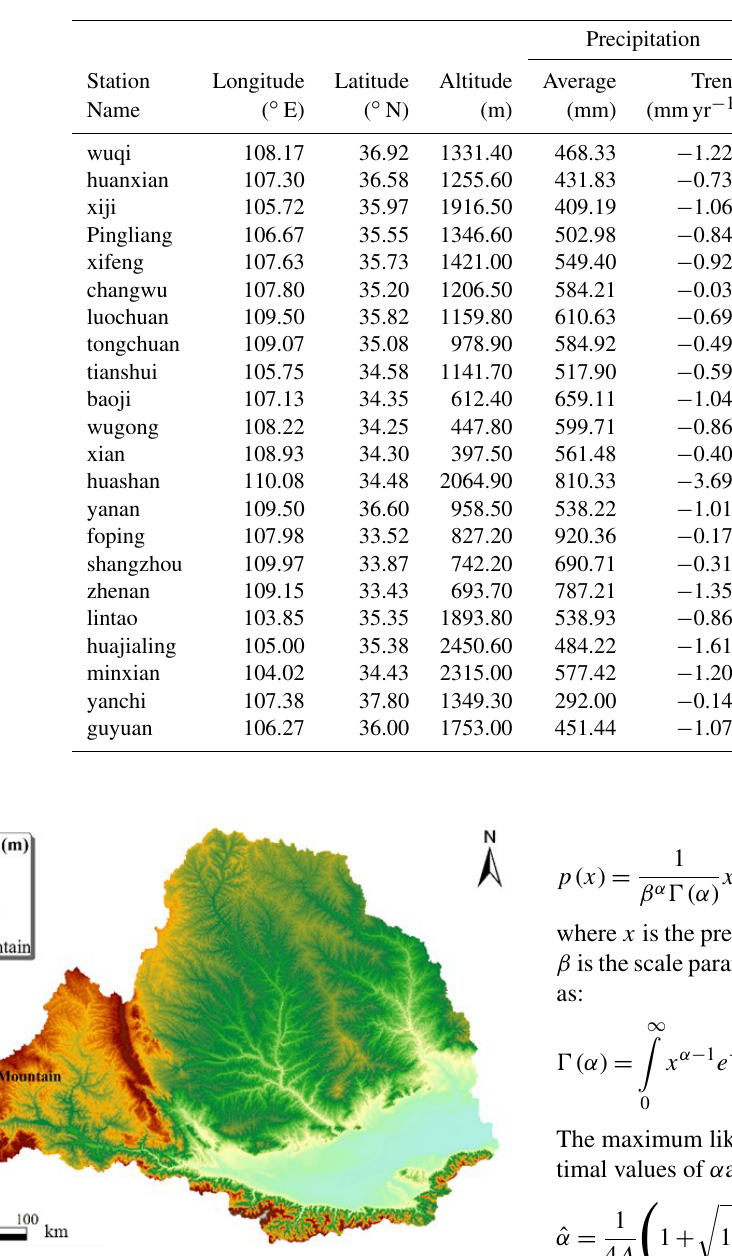
Figure 1. Distribution of meteorological stations in the Wei River Basin,